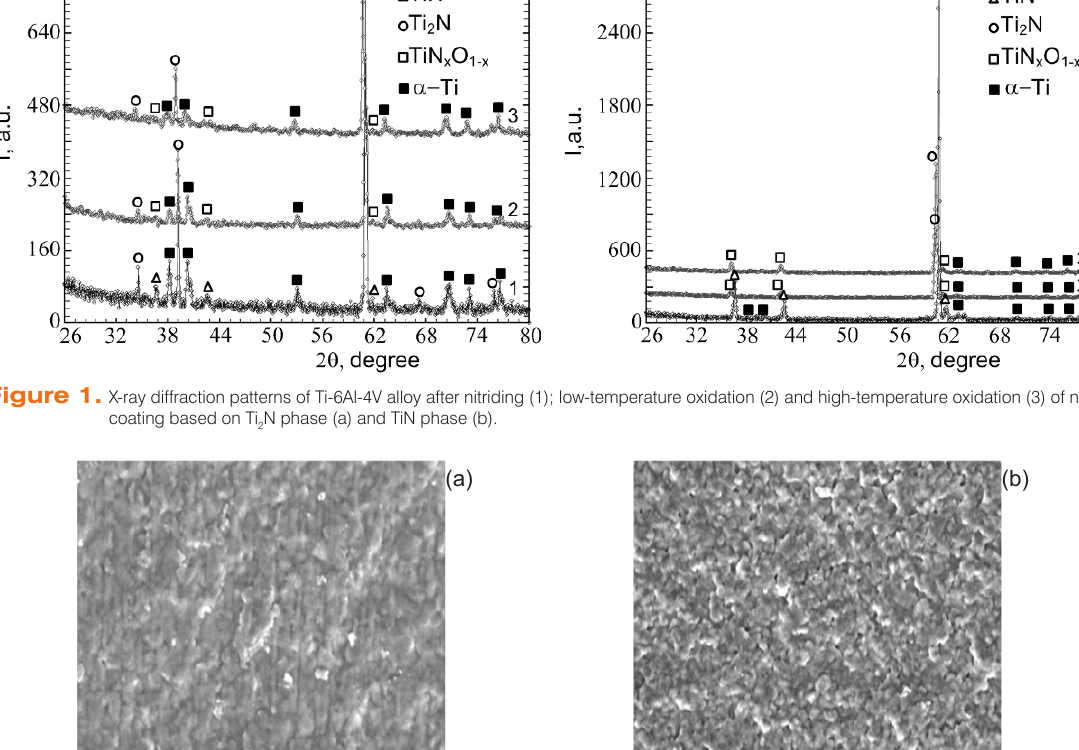
N phase (a) and TiN phase 2